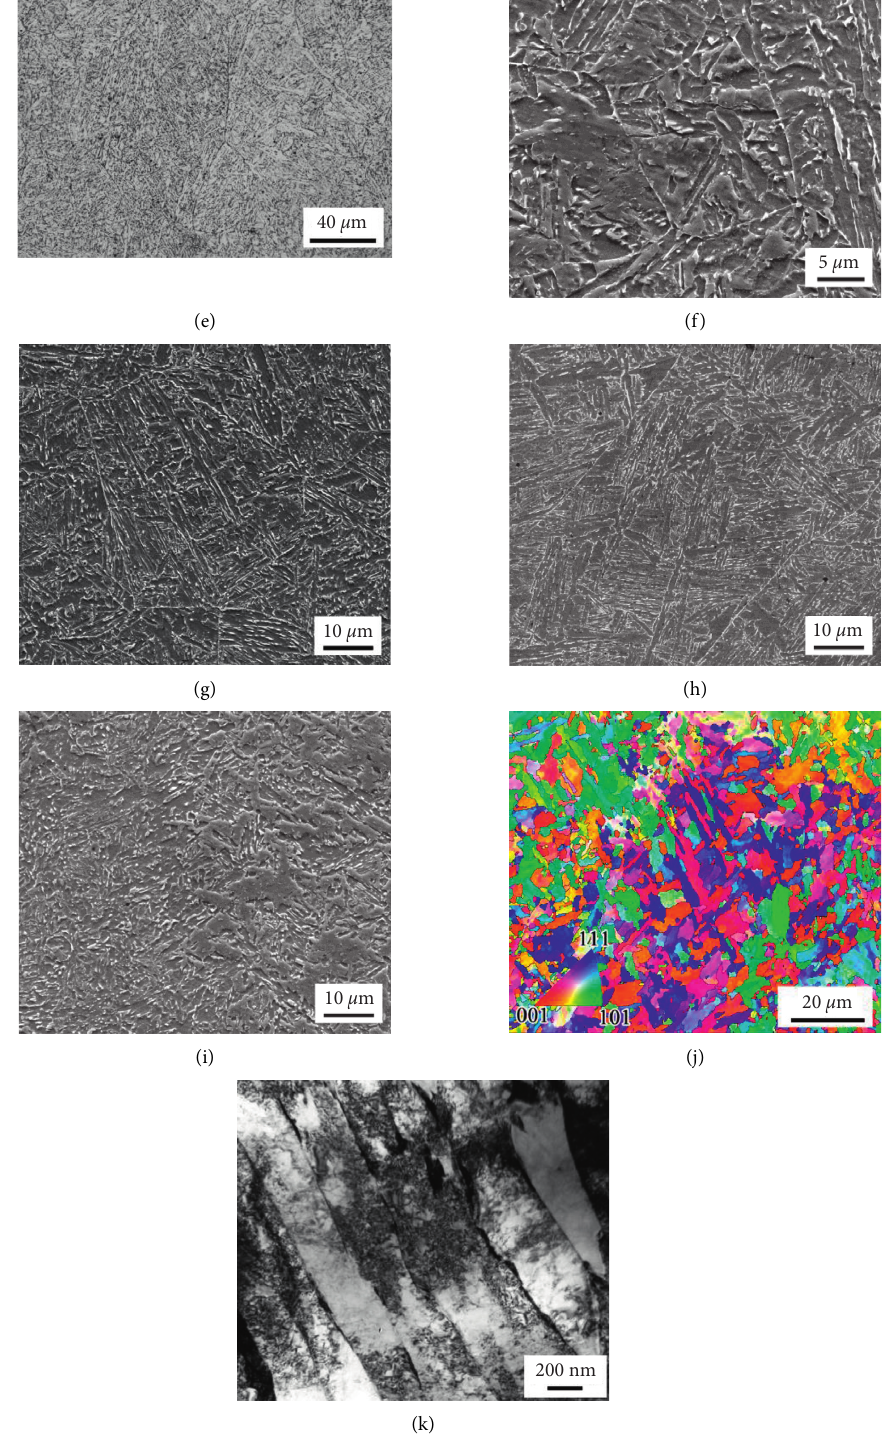
Figure 4: Microstructure of the deposit. (a) 3-D view of several passes; (b) YOZ view of passes; (c–e) OM and (f–i) SEM of the deposit; (c, g) equiaxial grain; (d, h) column grain; (e, i) coarse grain; (f) fine cellular grain; (j) IPF of a column grain (EBSD); (k) bainite laths